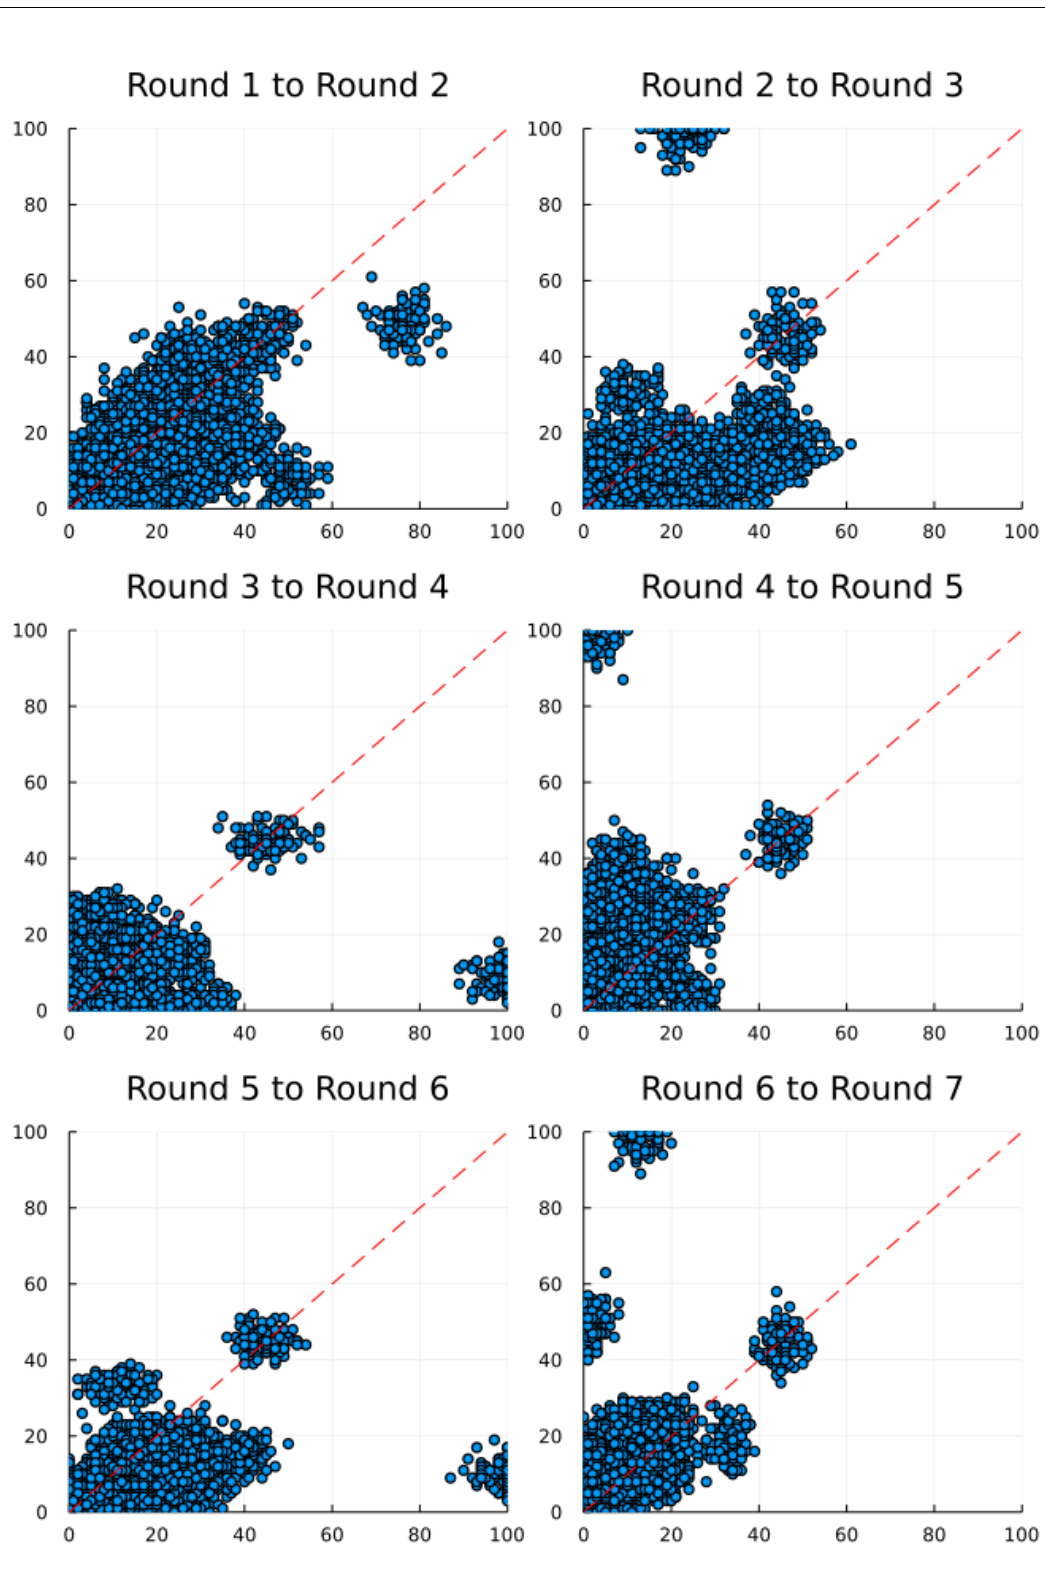
Figure 1. Individual game results. The blue dots denote the responses of all agents in our guess- ing